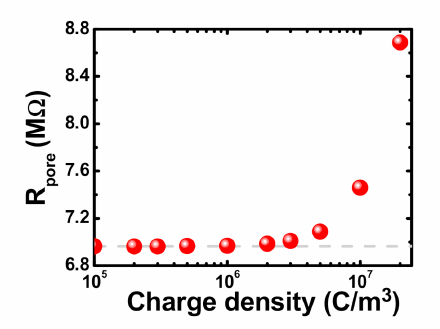
Figure 5. Resistance ( R pore ) of the considered mesopore system as a function of ρ PE in a 1000 mM / 1 mM salinity gradient. The dashed curve represents the result from the bare solid-state mesopore